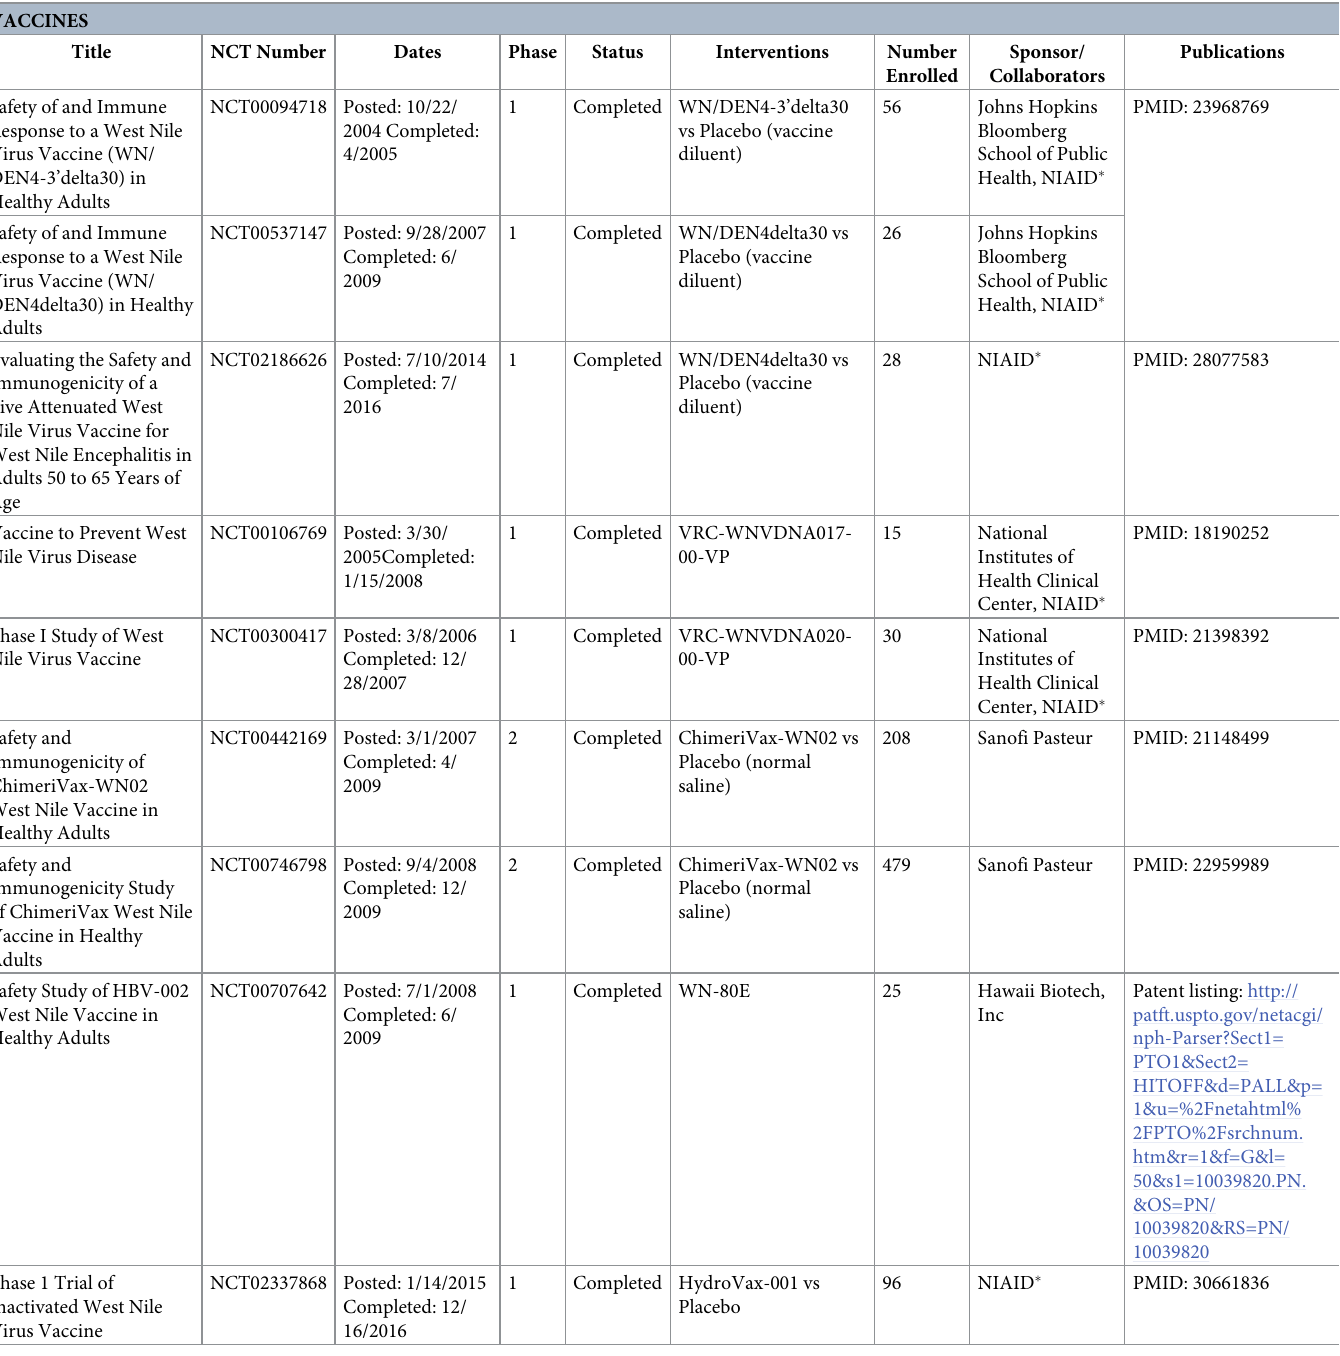
Table 1. Vaccine trials for